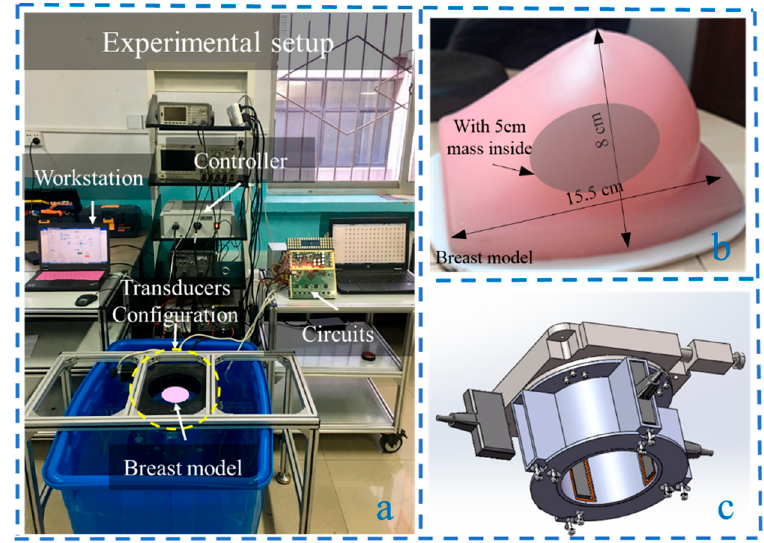
Figure 11. The experimental platform with cylindrical motion of piezoelectric micromachined ultrasonic transducer (PMUT) linear array. ( a ) Experimental setup. ( b ) Breast model. ( c ) Transducer configuration.